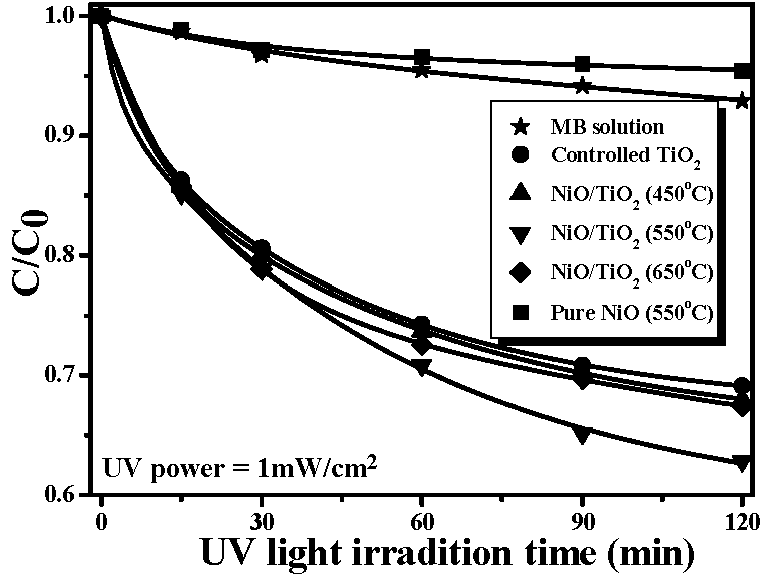
Figure 1. UV light-induced catalyses of the controlled TiO 2 film, the NiO/TiO 2 nanocomposite structures treated by the RTA (rapid thermal annealing) process at temperatures of 450 °C, 550 °C, and 650 °C, respectively, and the pure NiO film treated by the RTA process at 550 °C to degrade the MB (methylene blue) solution (the degradation of the MB solution directly irradiated by the UV light is provided for